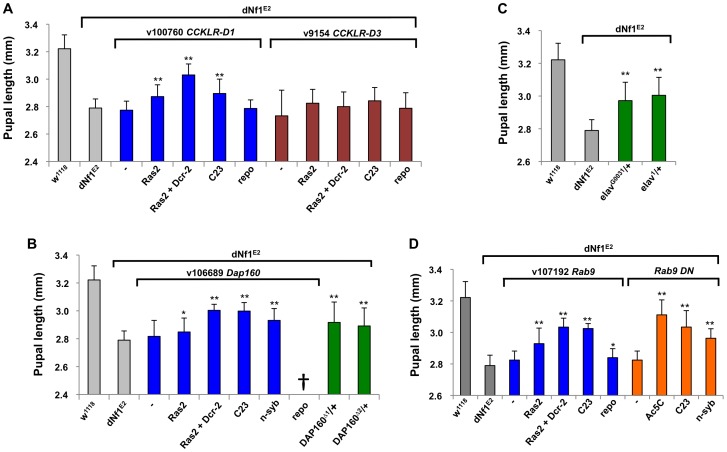
Validation of dNf1 modifiers with neuronal functions.(A) Ras2-Gal4 or C23-Gal4 driven neuronal RNAi knockdown of CCKLR-17D1 but not CCKLR-17D3 suppressed the dNf1 pupal size defect. (B) Identification of dynamin-associated protein 160 (Dap160) as a suppressor of dNf1 growth. Neuronal RNAi targeting of Dap160 increased dNf1 pupal size as did two Dap160 loss-of-function alleles. (C) Two elav alleles dominantly suppress the dNf1 size defect. (D) Neuronal expression of a Rab9 RNAi transgene or of a dominant negative Rab9 mutant suppresses the dNf1 size defect.